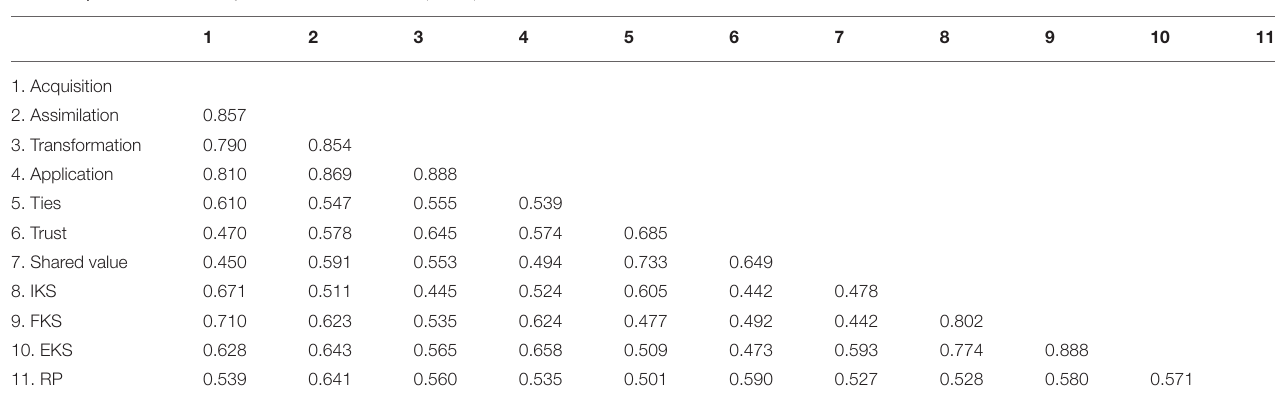
TABLE 2 | Discriminant validity: Heterotrsait–monotrait